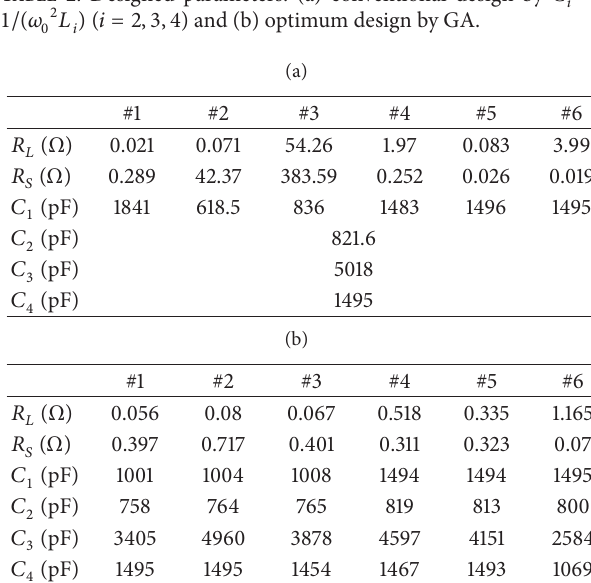
Table 2: Designed parameters: (a) conventional design by 𝐶 𝑖 = ) ( 𝑖 = 2,3, 4 ) and (b) optimum design by 1/(𝜔 02 𝐿 𝑖